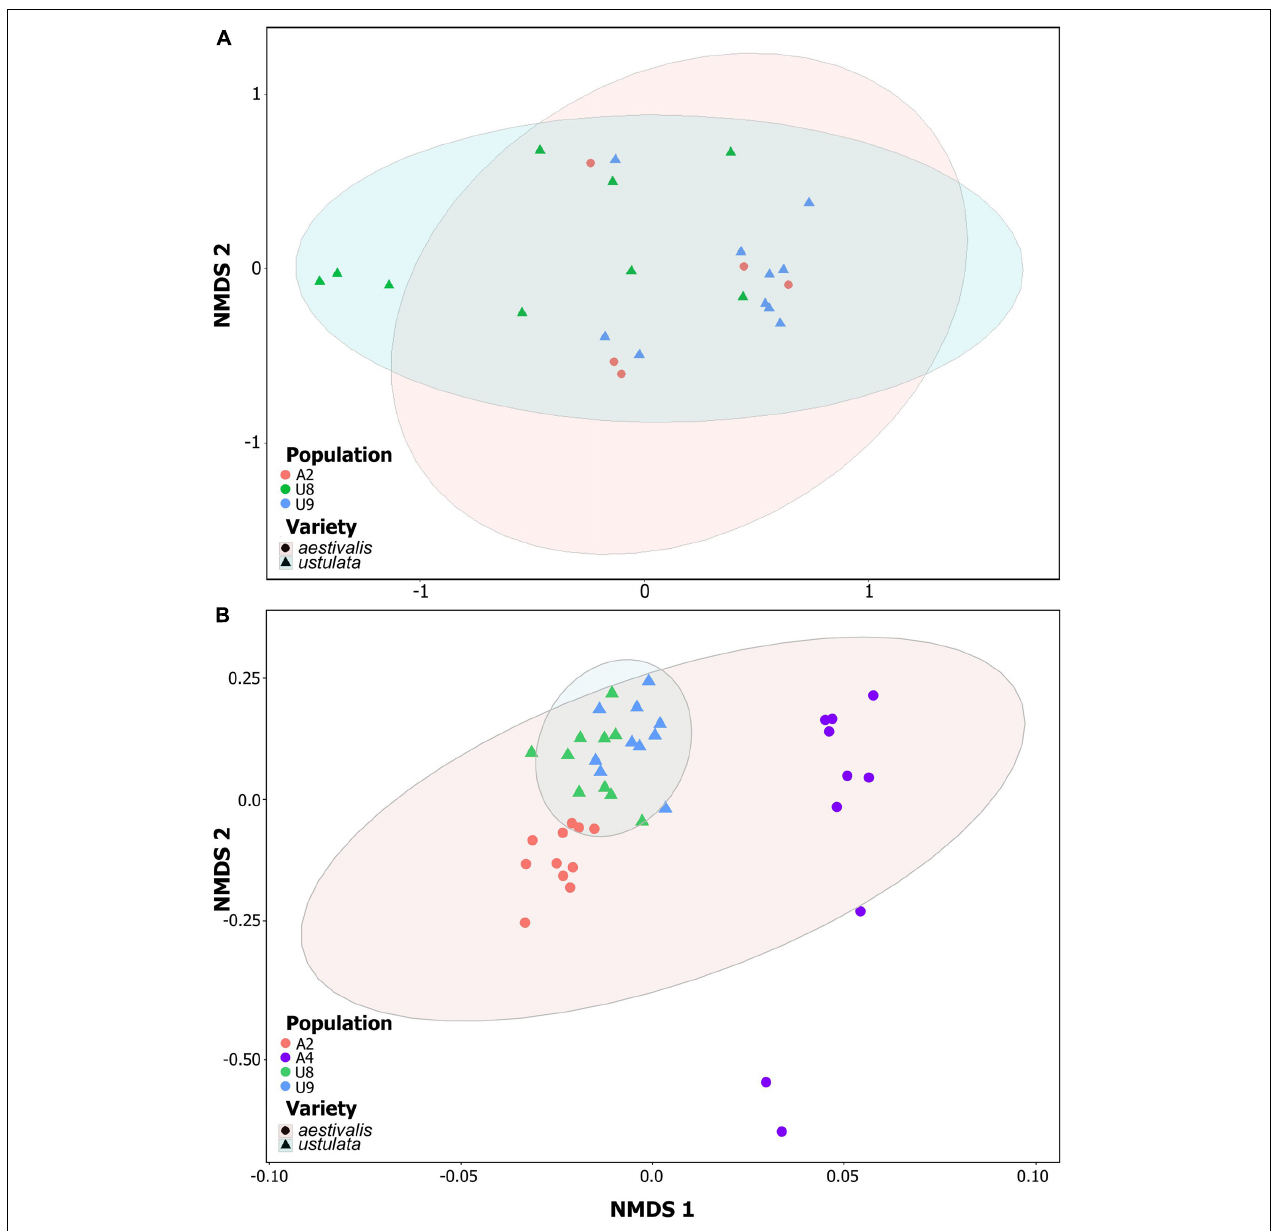
FIGURE 5 | Comparison of floral scent composition between Neotinea ustulata varieties in a non-metric multidimensional scaling (NMDS) based on semi-quantitative Bray-Curtis similarities: (A) headspace (stress = 0.15), and (B) solvent extracts (stress = 0.09). Different symbols represent different varieties and different symbol colors represent different populations (see Supplementary Table 1 for population codes). Ellipses display 95% confidence area of each